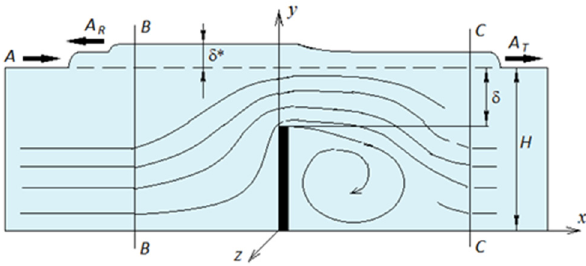
Figure 14. Schematic diagram of the interaction of a tsunami-type wave with a thin impenetrable barrier. Shallow water theory is not applicable near the barrier: − L/2 < x < + L/2 .